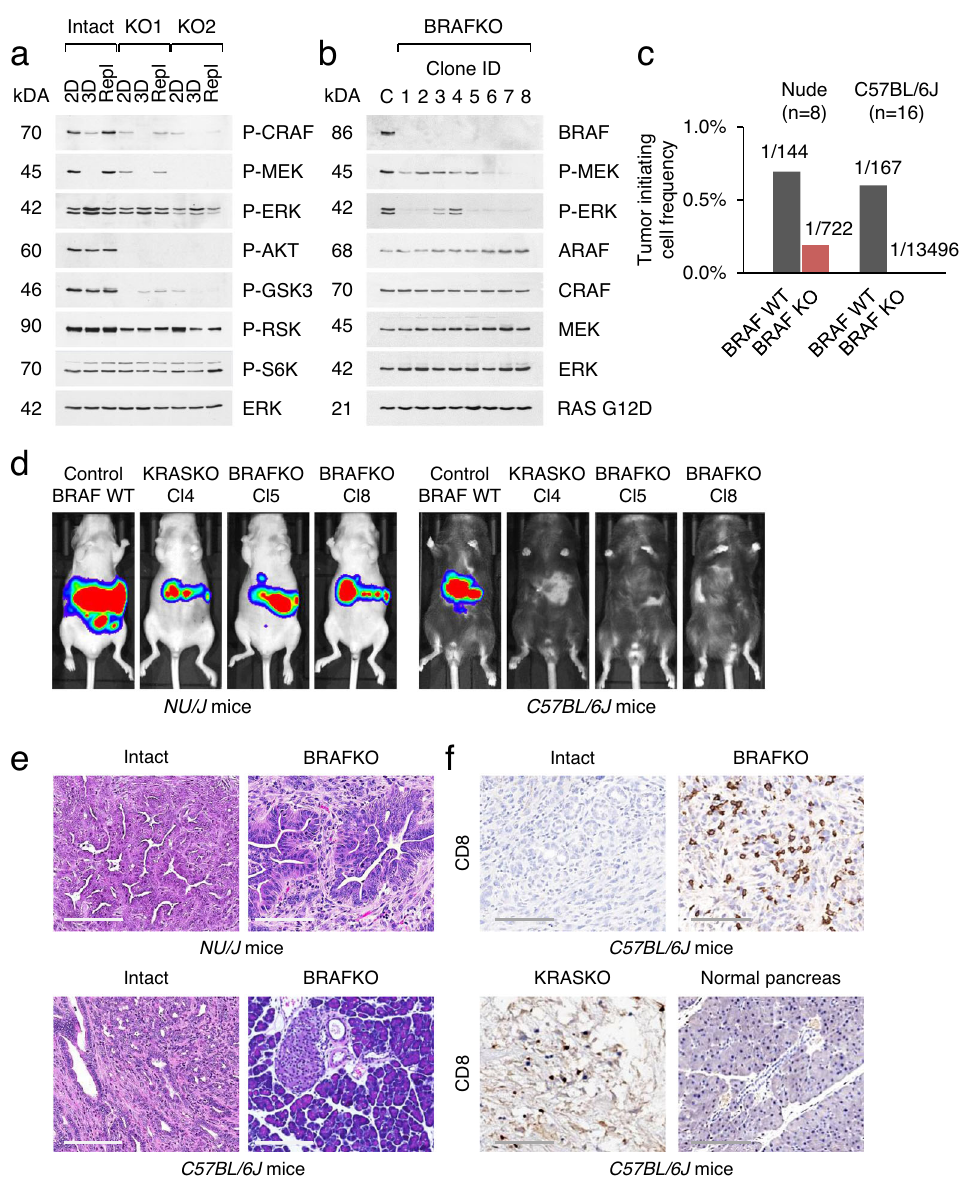
Fig. 6 Inactivation of BRAF impairs the growth of KRAS mutant PDAC. a Western blot analysis of parental KRAS intact and KRAS KO cell clones maintained in adherent (2D) or suspension culture (3D) for 3 days. Cells maintained in 3D culture retain adhesive capacity when replated (Repl) on tissue culture dishes. b Immunoblot analysis of clonal BRAF KO KPC cell lines. For convenience, cell lines are numbered sequentially. c Tumor-initiating cell frequency of parental KRAS intact and averaged four BRAF KO KPC cell lines (Cl5, 6, 7, and 8) in nude and syngeneic wild-type mice. Source data are provided as a Source Data fi le. d Bioluminescence imaging of tumor development by Luc-expressing cell lines of the indicated KRAS and BRAF genotypes two weeks post-implantation. Each designated cell line was transplanted into two mice, and one representative mouse is shown. e Histological appearance of orthotopic tumors derived from KRAS intact KPC cells and their derivatives lacking BRAF. Scale bar 200 μ M. f IHC staining of representative tumors shown in ( d